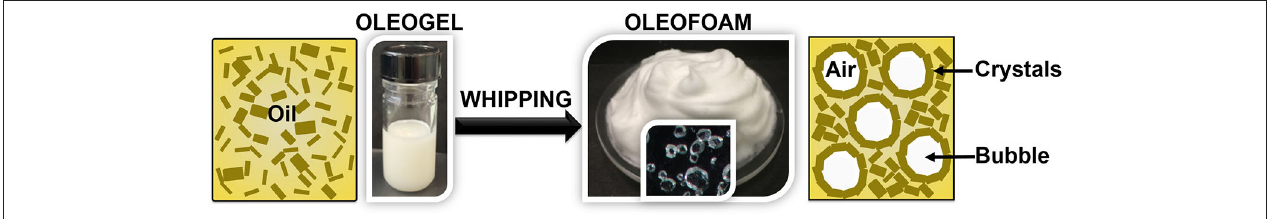
FIGURE 1 | By whipping an oleogel containing crystals inside a liquid oil, oleofoams are obtained. Crystals stabilize the oleofoam due to their presence in bulk and at the interface as observed by optical